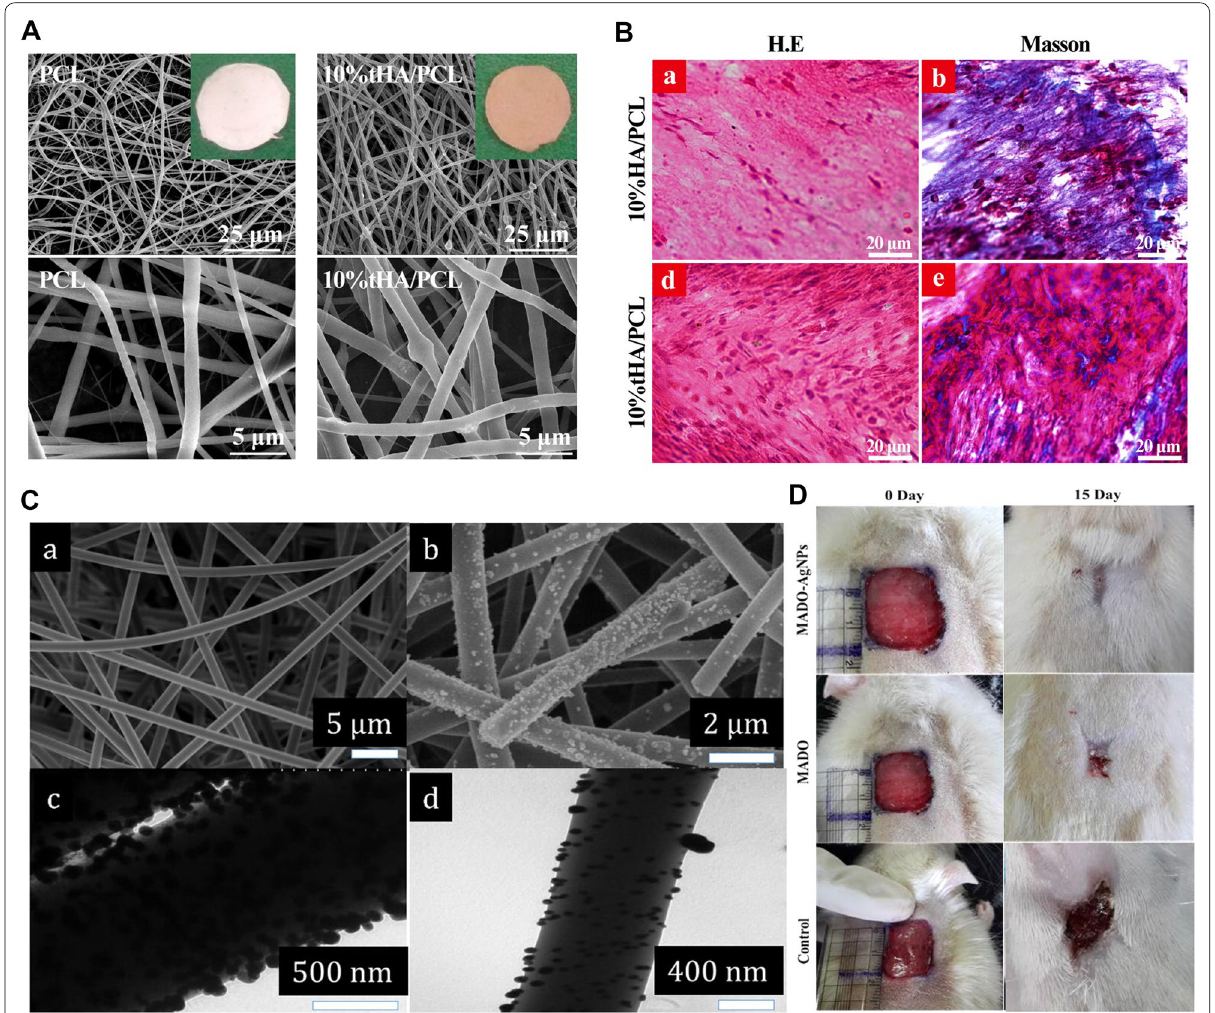
Fig. 3 A SEM images of PCL and 10% tHA/PCL nanofibers. B H&E and Masson staining of hMSCs‑10% HA/PCL (top) and hMSCs‑10% tHA/PCL (bottom). Reproduced with permission from [96], American Chemical Society (ACS). C FESEM images of electrospun (top, left) MADO nanofibers and (top, right) MADO/AgNPs‑coated nanofibers. TEM images of MADO/AgNPs‑coated nanofibers after 24 h (bottom, left) and 12 h (bottom,